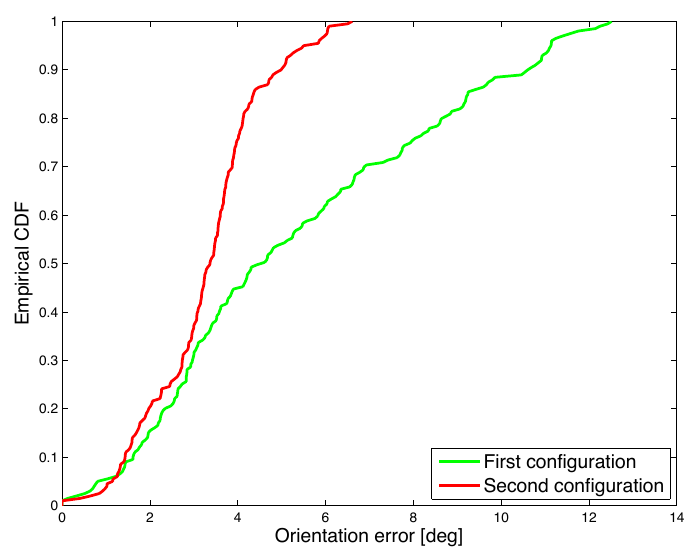
Figure 14. Experimental results: CDF of the orientation error under two orientation configurations. The green line (first configuration) is related to the test performed with the initial orientation of transmitter coil a = 0, b = 0 and c = 1, the red line (second configuration) is related to the test performed with the initial orientation of transmitter coil a = 0.72361, b = − 0.52573 and c =